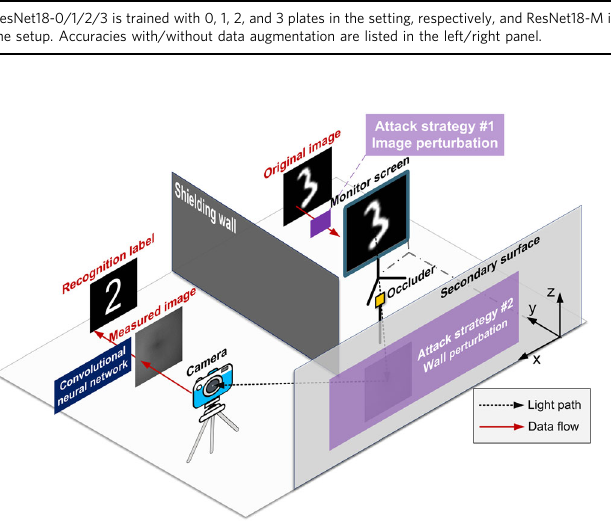
Fig. 4 Schematic of non-line-of-sight attacks. Attack strategy #1 attack on the monitor screen: image perturbations are added on the original image to create an adversarial example, which is displayed on the monitor screen to cause misclassi fi cation; Attack strategy #2 attack on the secondary surface: wall perturbations are added on the secondary surface to change the measured image and cause misclassi fi cation.